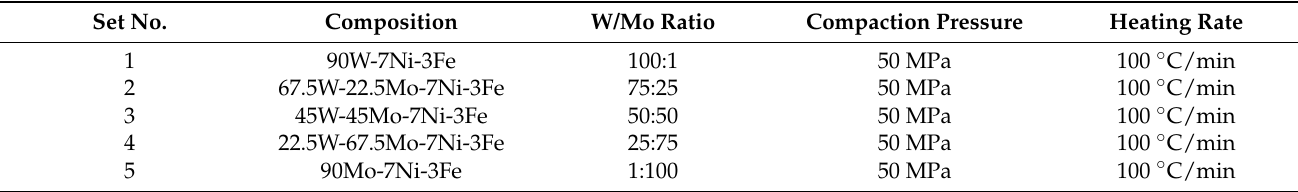
Table 2. Compositions of samples and experimental